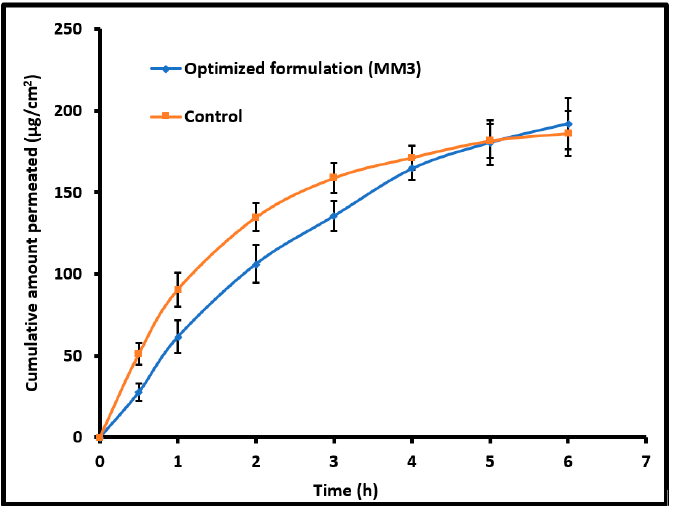
Figure 5. Comparison of moxifloxacin ex vivo permeation across the isolated rabbit cornea membrane from optimized nanoemulsion (MM3) and control (commercial eye drops). The data represents average ± SD of six trials.